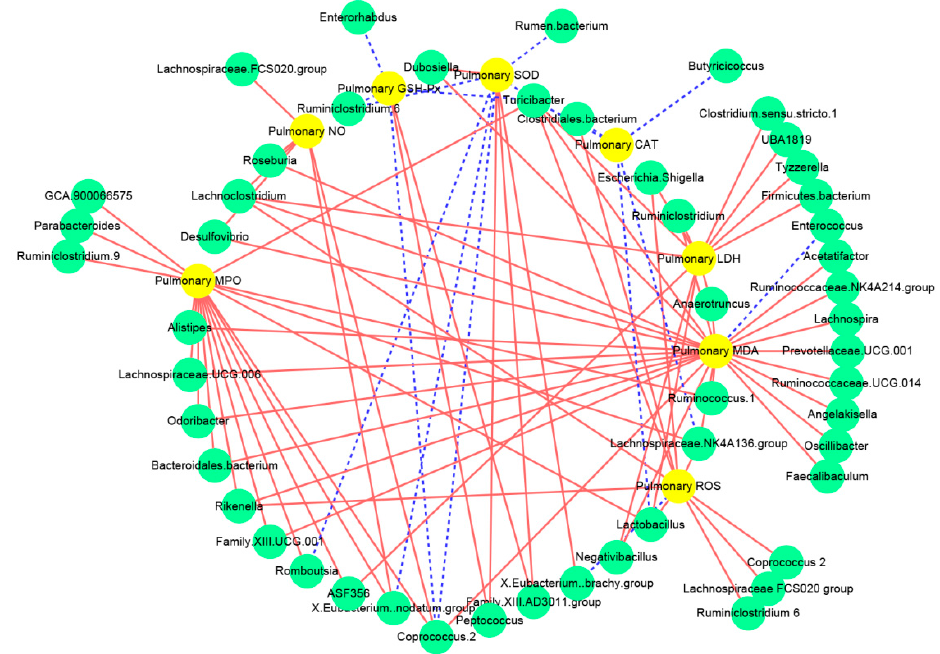
Figure 6. Correlation network established between intestinal microbiota and oxidative stress related to lung injury: The solid red line and dotted blue line represent the positive and negative correlation, respectively. In addition, the line width indicates the strength of correlation.